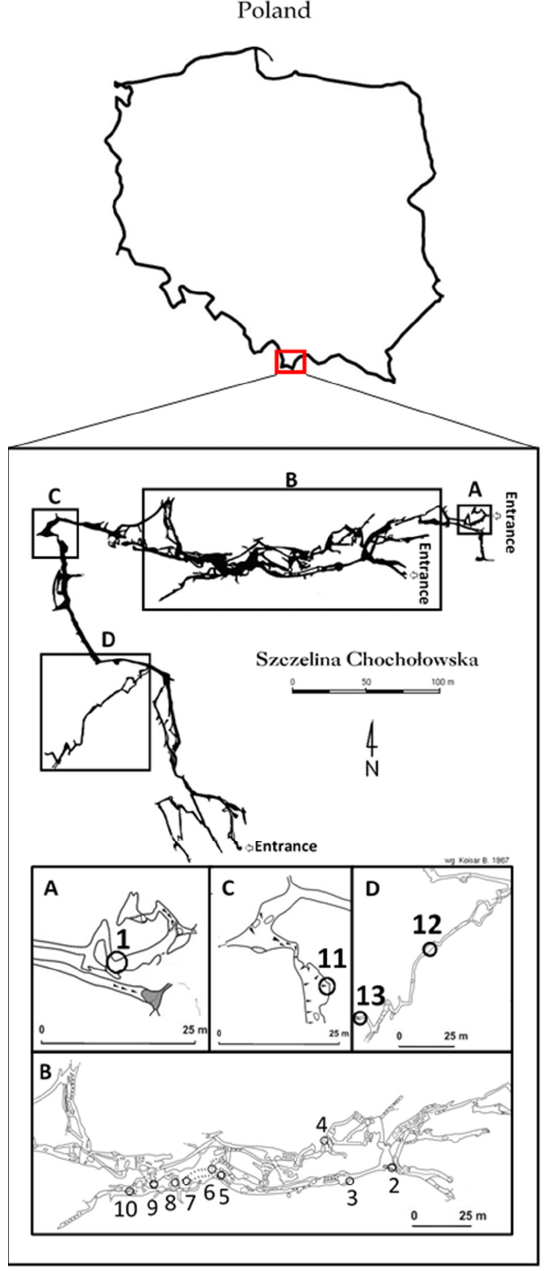
Figure 1. A map of the Szczelina Chocho ł owska cave (19°48’43 ″ .140 E 49°14’45 ″ .401 N) (WGS84 coordinates). A map of Poland is shown at the top of the figure with the square indicating the region in which the cave is located. Regions marked as ( A )–( D ) are enlarged at the bottom of the figure. Numbers indicate places of collection of samples. Details are described in Section 4.2.